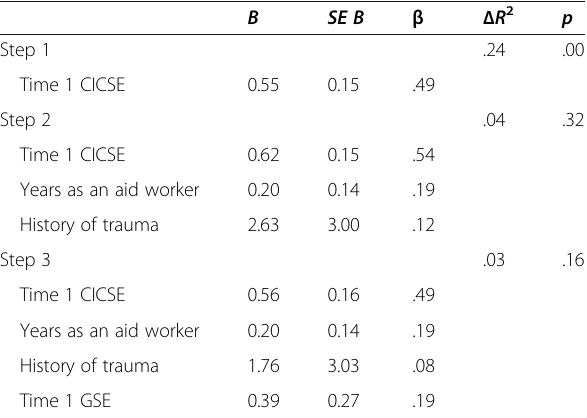
Table 7 Multiple regression analysis for time 2 CICSE accounting for history of